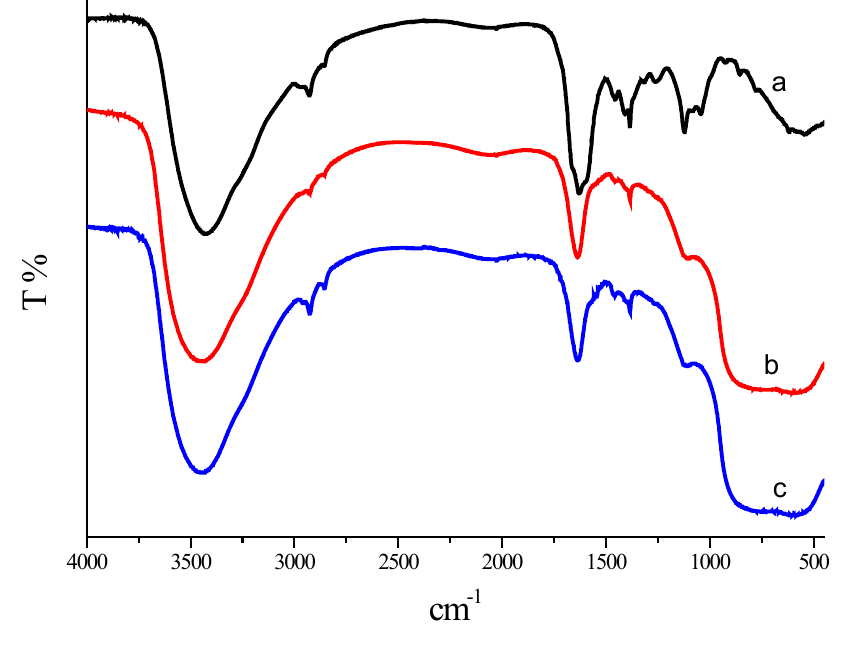
Figure 7. FTIR spectra of the Mb (Curve a); the un-calcined Au/Al 2 O 3 catalyst